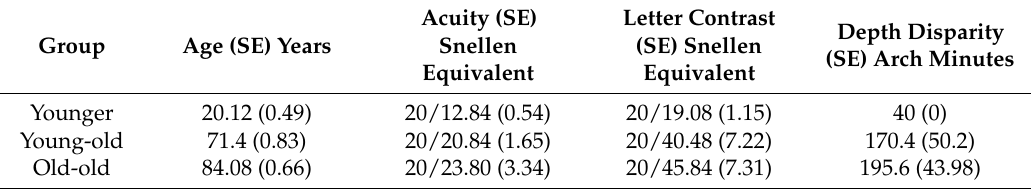
Table 1. Mean age and visual demographics and standard error (SE) for younger, young-old and old-old adults.